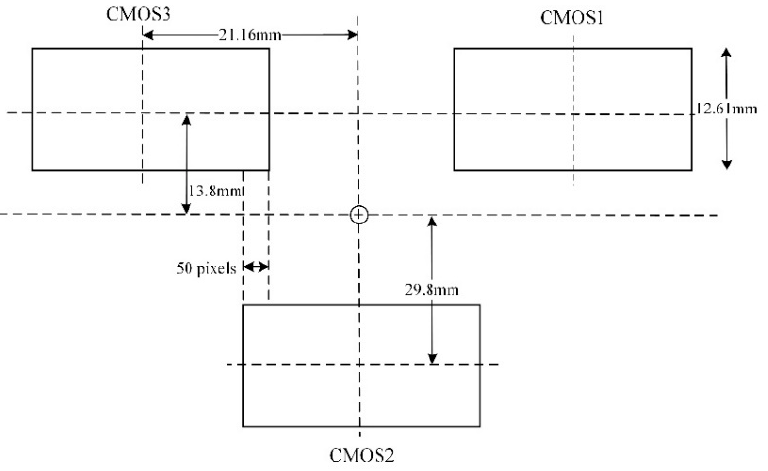
Figure 1. Focal plane arrangement for the hyperspectral camera. The width of each CMOS image is 50 km, and the inter slice overlap is 50 pixels.